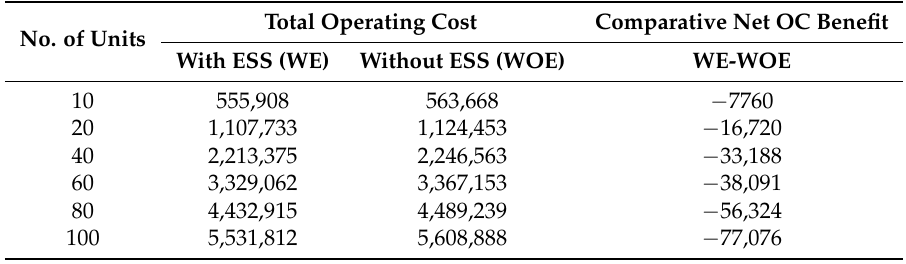
Table 1. A comparison of total operating cost without energy storage system (ESS) and with ESS [103]. Total Operating Cost Comparative Net OC No. of Units